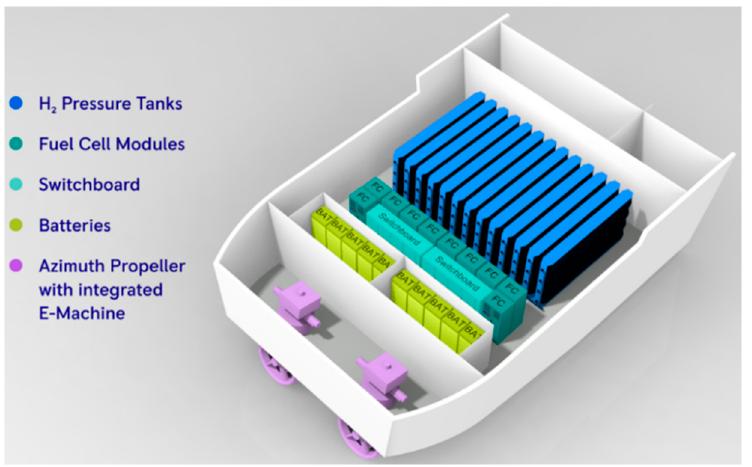
Figure 42. A propulsion system with fuel cells and batteries for tugboats, which was designed by Rolls-Royce Group PLC [189].